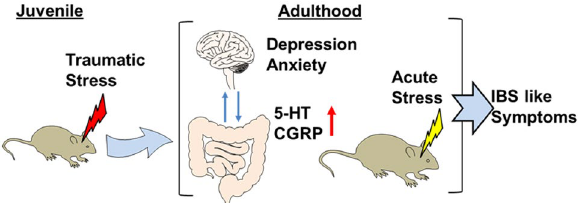
Figure 8. The schematic diagram of the juvenile SDS induced IBS-like symptoms in adulthood. Juvenile traumatic SDS caused anxiety-/depression-like behaviors, and an increase of CGRP/5-HT expression in large intestine on adulthood. Juvenile SDS mice showed vulnerability against acute restraint stress and IBS-like symptoms such as visceral hypersensitivity, psychiatric symptoms, and motility disorder on adulthood. Image was generated using Motifolio illustration tool kit (Motifolio Inc., Ellicott City, MD,